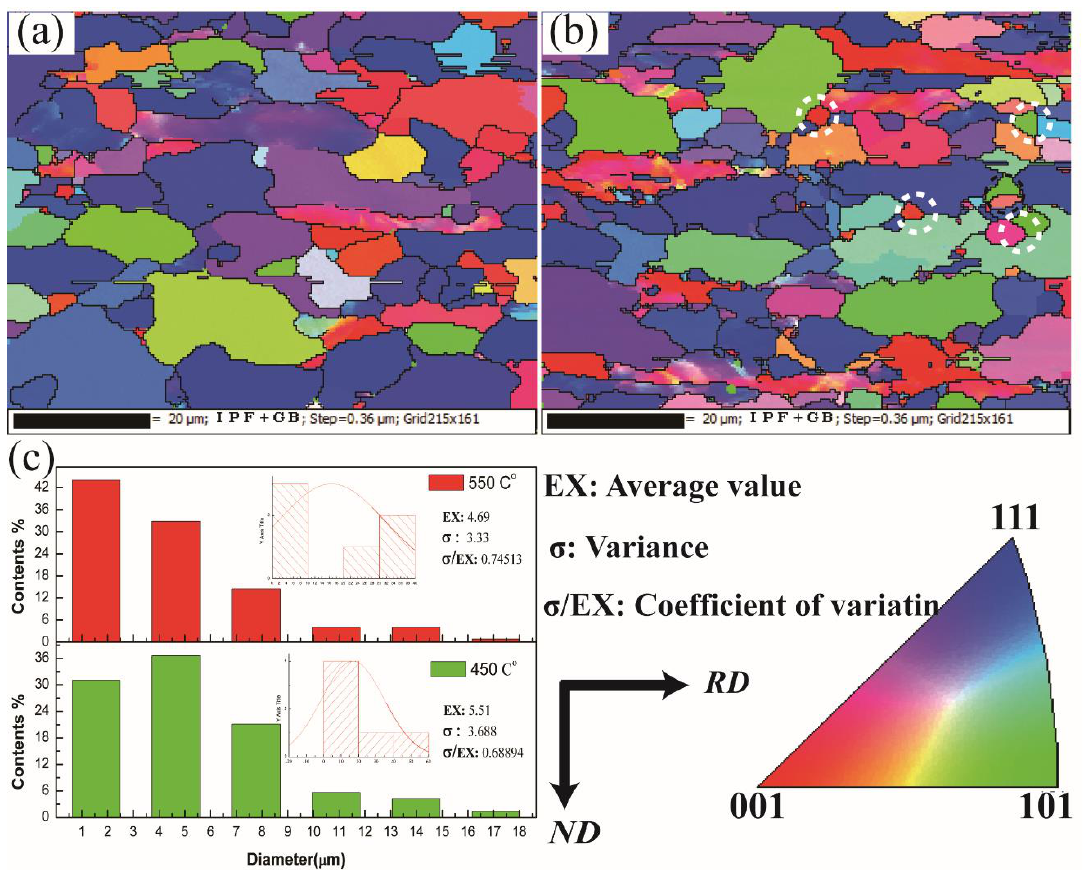
Figure 11. IPF map of the annealing sheet. ( a ) 450 °C; and (b ) 550 °C: fine grains; and ( c ) grain size distribution.